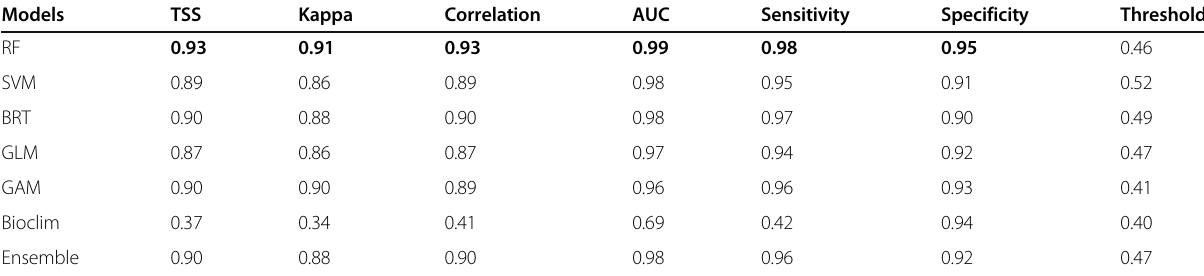
Table 3 Performance evaluation of SDMs using different statistical parameters. Sensitivity and specificity describe the rate of true positive and negative respectively Models